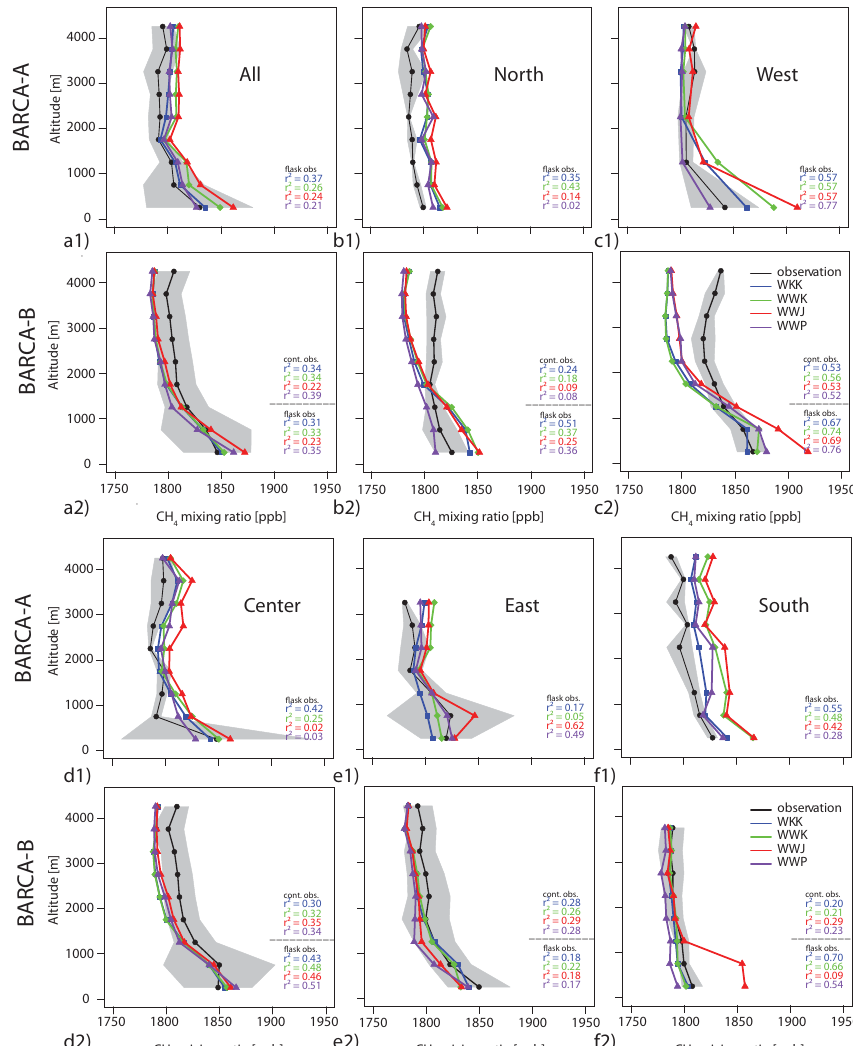
Fig. 8. Comparison of BARCA-A (1) and BARCA-B (2) observations (black) to different WRF simulations with adjusted wetland component (WKK – blue; WWK – green; WWJ – red; WWP – violet) binned in 500m vertical profiles for five different region of the Amazon basin. The regions are defined as follows: (a) north: latitude > − 1.0 ◦ and longitude > − 62.0 ◦ (b) west: latitude > − 5.0 ◦ and longitude < − 62.0 ◦ (c) central: latitude > − 5.0 ◦ and latitude < − 1.0 ◦ and longitude > − 62.0 ◦ and longitude < − 58.0 ◦ (d) east: latitude > − 5.0 ◦ and latitude < 0.0 ◦ and longitude > − 58.0 ◦ (e) south: latitude < − 5.0 ◦